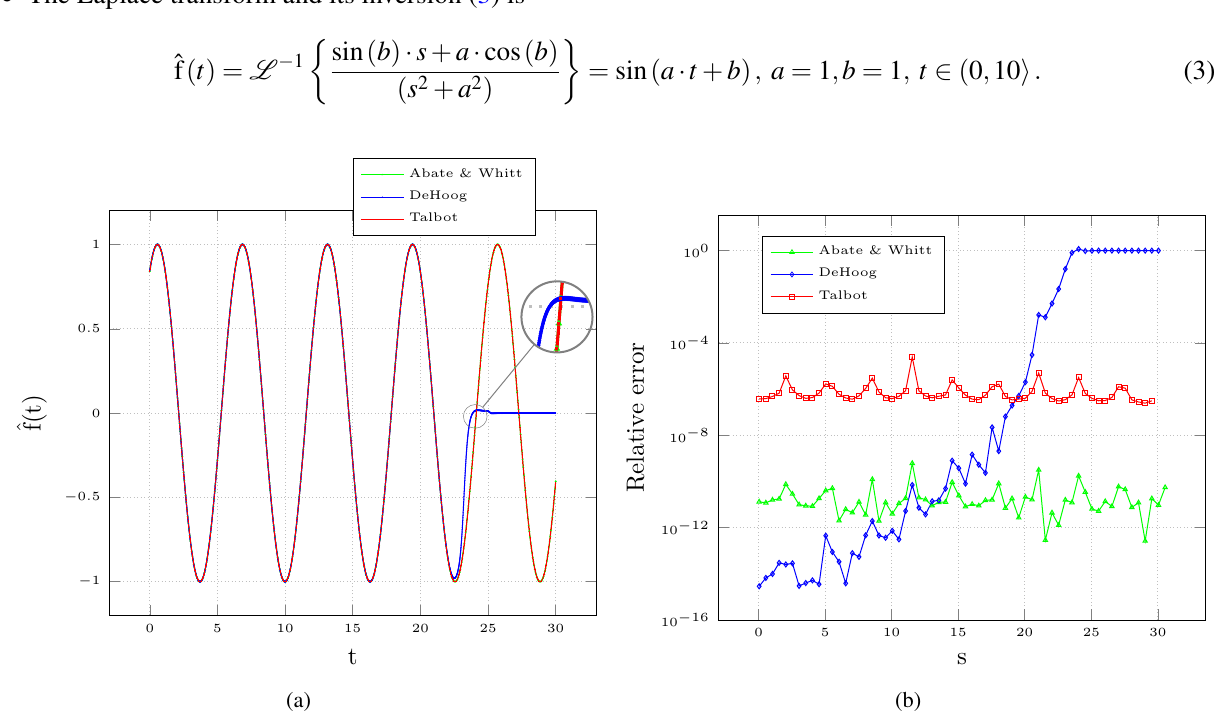
Fig. 3 Plots of numerical inversions ˆf ( t ) of the Laplace transform (3) (a) and their relative errors (b) for applied methods in interval ( 0 , 30 (cid:105)